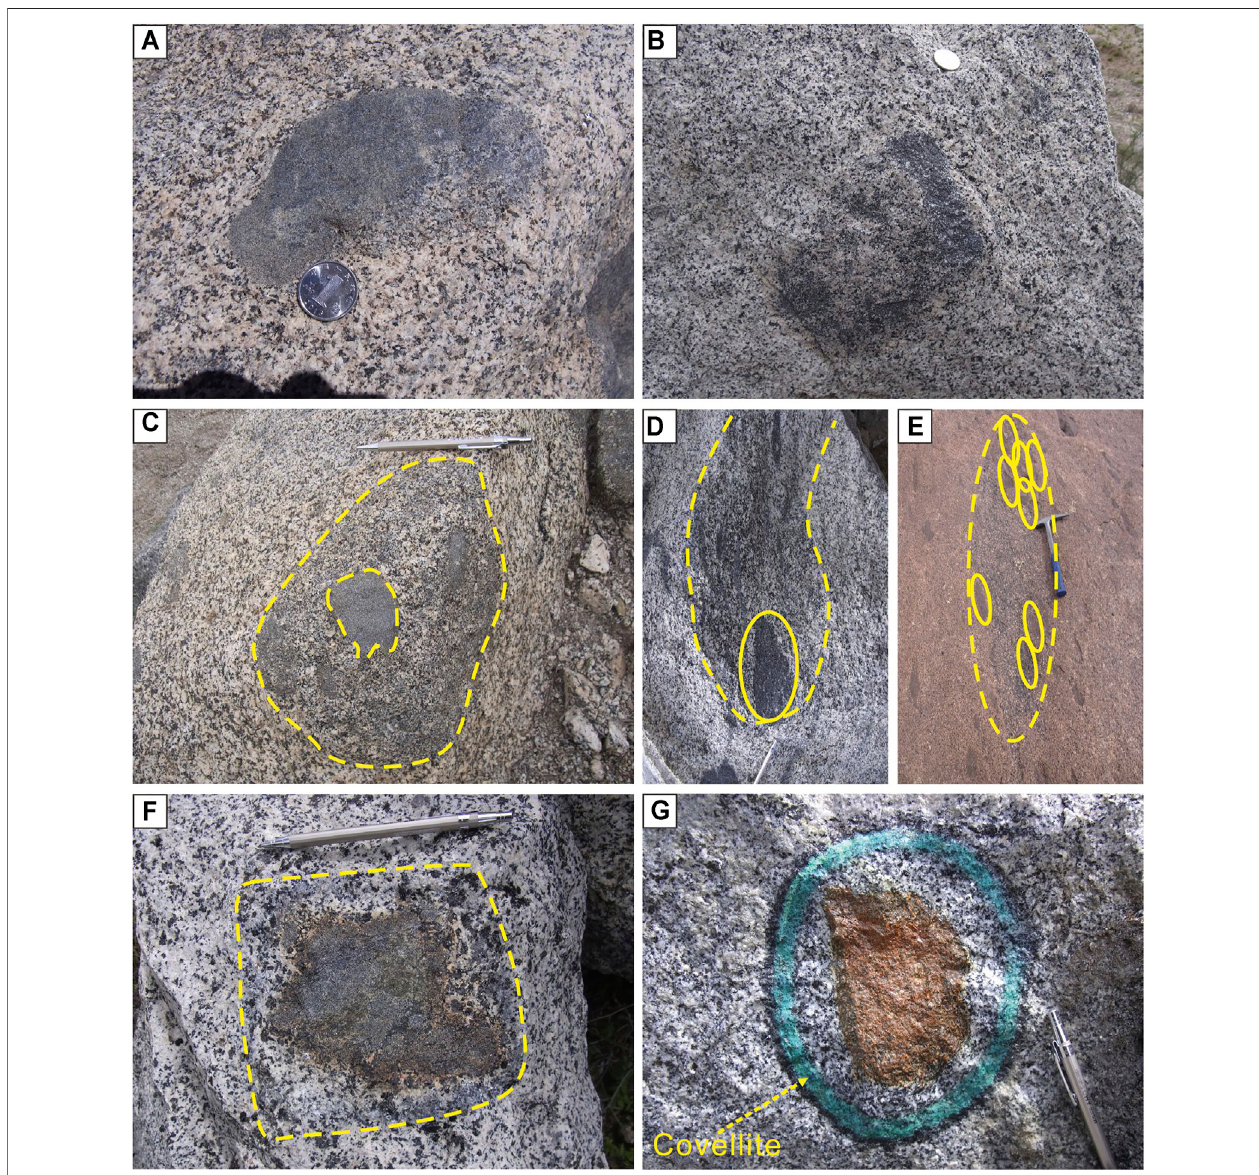
FIGURE 6 | Field photos showing the composite enclaves. (A,B) Variable interaction of the enclaves with the enclosing host rock, with the lower right side of the enclaveexhibitingagreaterdegreeofinteraction withthehost. (C – F) Doubleenclaveswiththeoutlineoftheoriginalenclaves. (G) Anenclaveshowingaroundedmargin of copper, revealing the interaction of the enclave with the host granitoid magma.